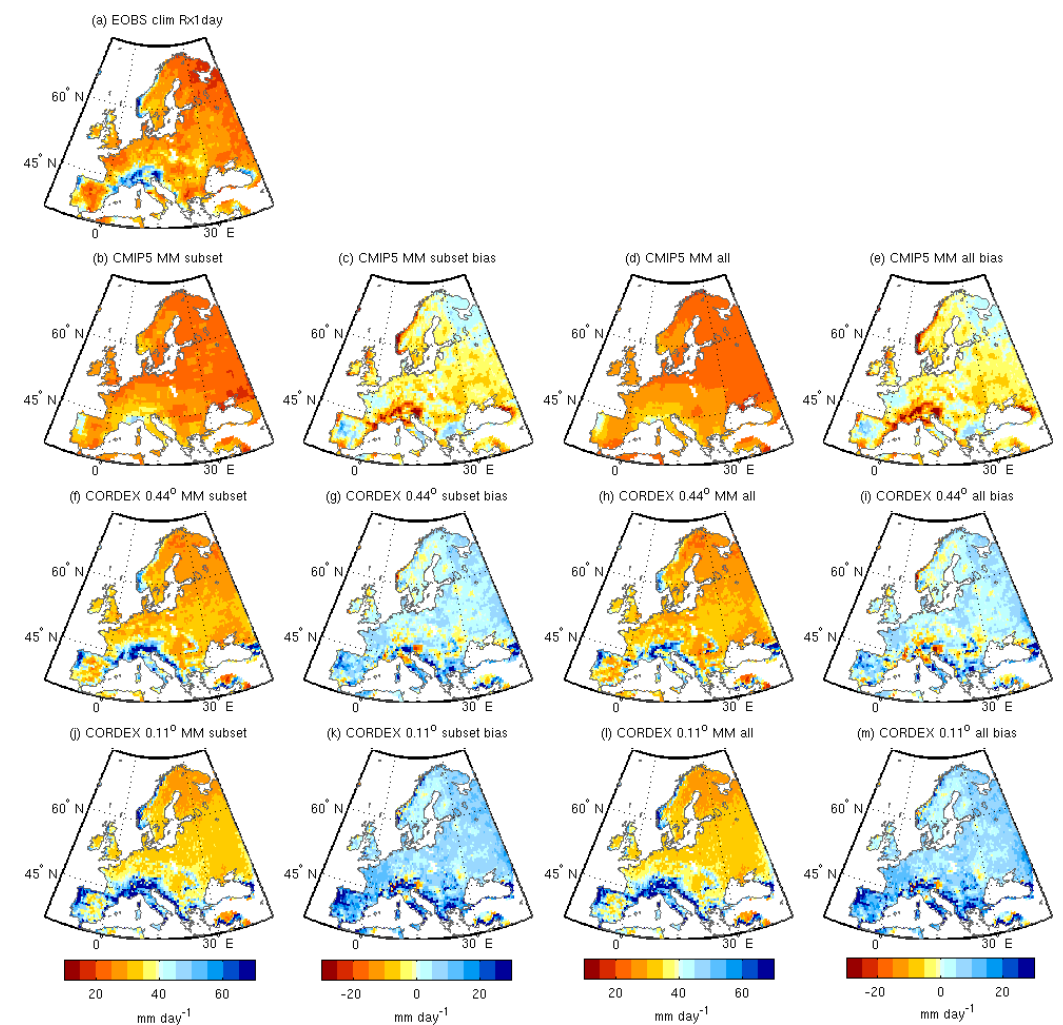
Figure 3. As for Fig. 1 but for the climatological mean of Rx1day. Units: